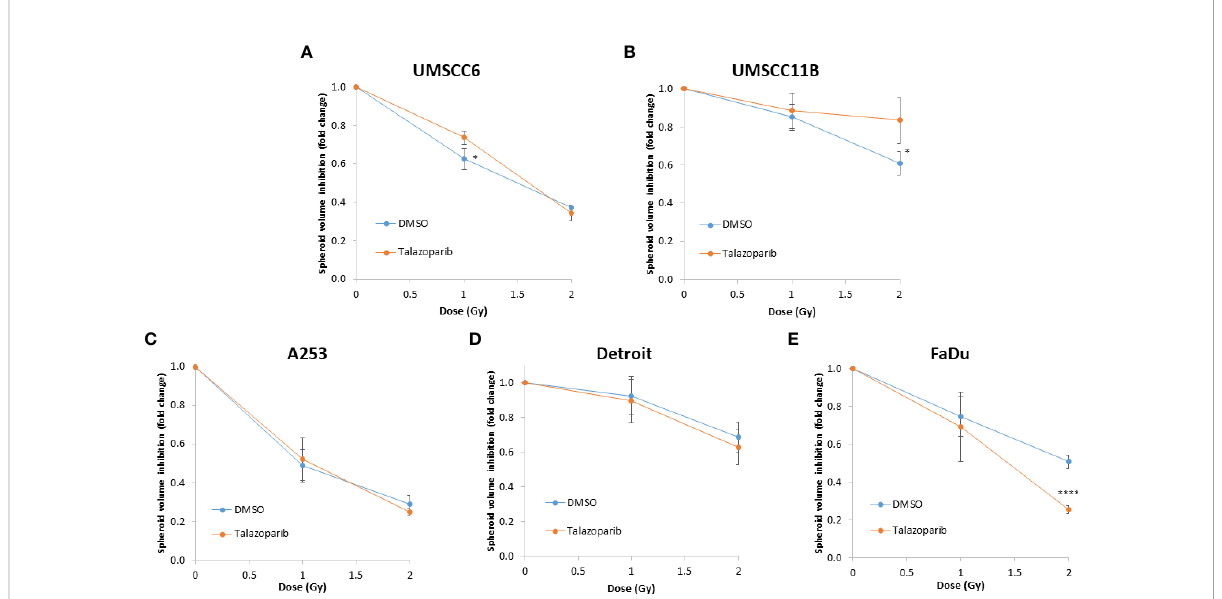
FIGURE 6 Impact of talazoparib on the enhancement of the radiosensitivity of HPV-negative HNSCC spheroids. (A – E) The fold growth of HPV-negative HNSCC spheroids from days 3 to 12 post-seeding was determined relative to the x-ray radiation dose, and this was normalised to the unirradiated control which was set to 1.0. *p < 0.05, ****p < 0.001 as analysed by a two sample